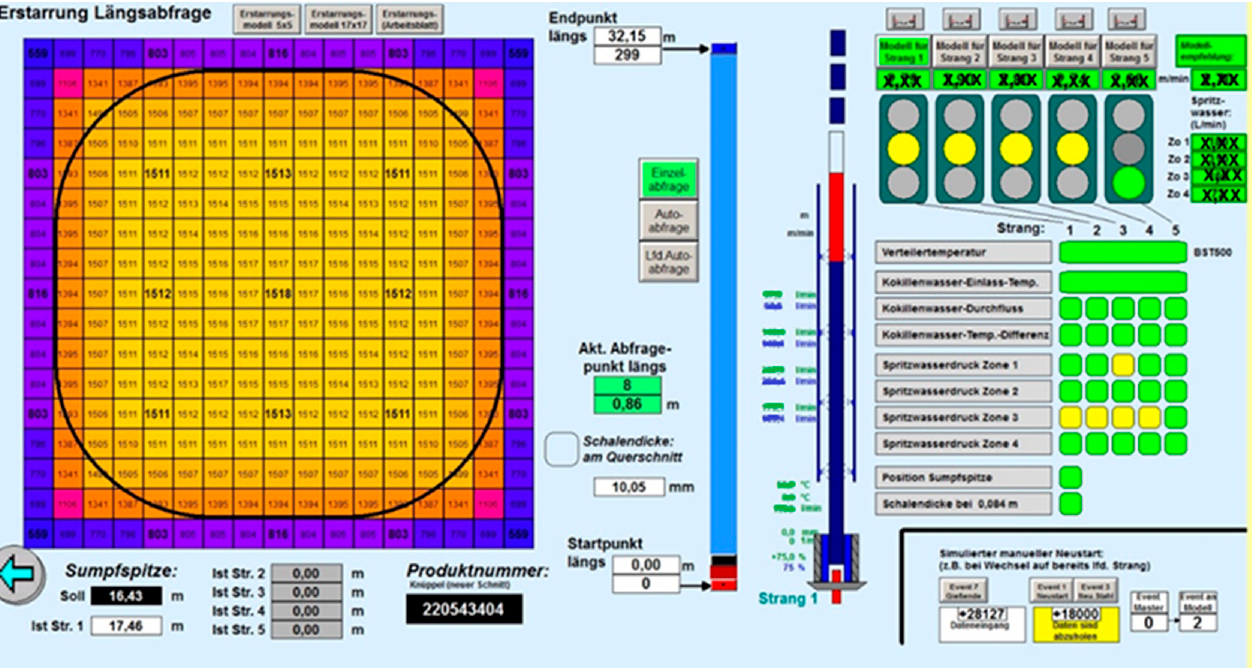
Figure 3. HMI in ESF control room with results from DynSolidCC functions as well as traffic light system.